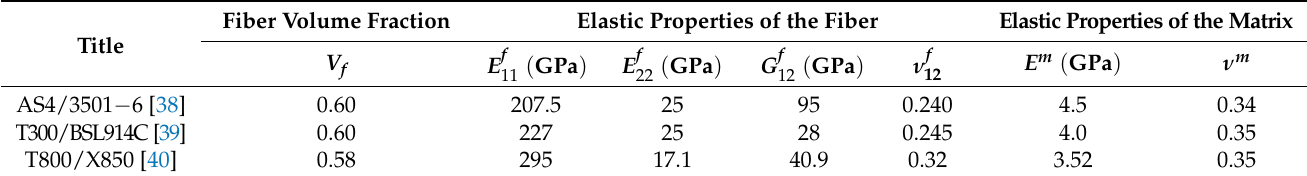
Table 1. Material properties of the constituent of the three unidirectional composites.